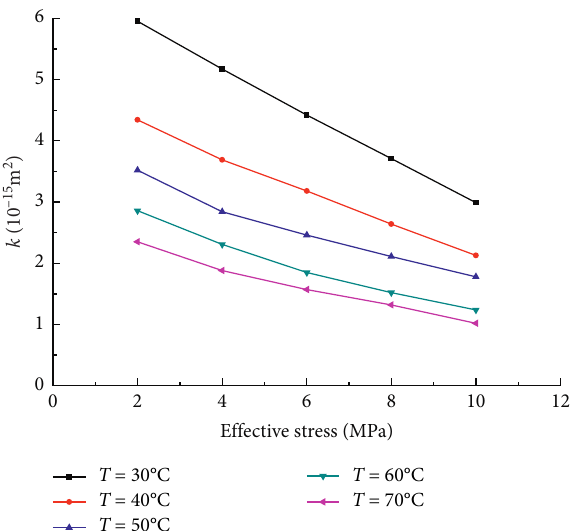
Figure 3: Percolation rate of coal with effective stress under different temperatures at the gas pressure of 0.3MPa.